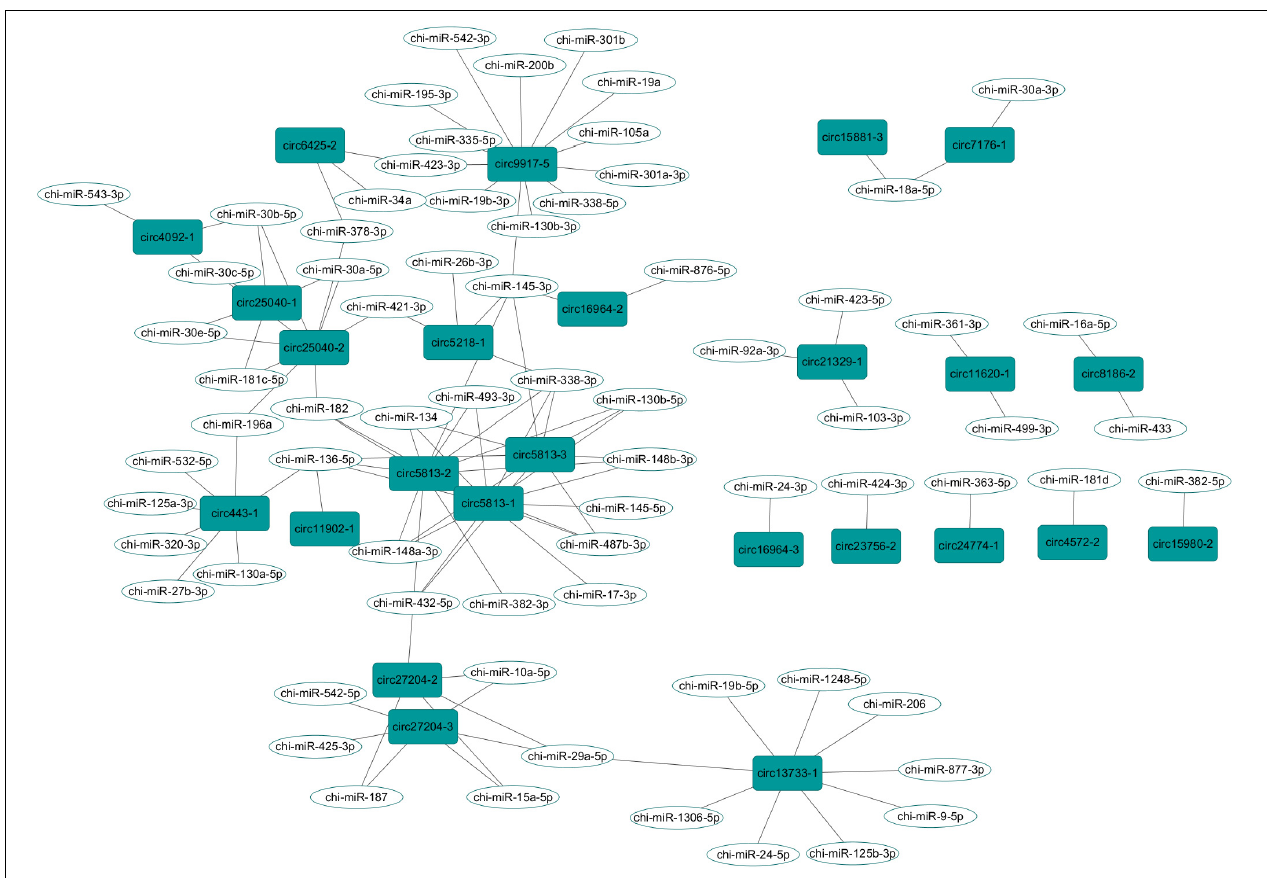
FIGURE 5 | The circRNA-miRNA interaction network in the goat rumen during fetal and prepubertal periods, Including 27 circRNAs and 71